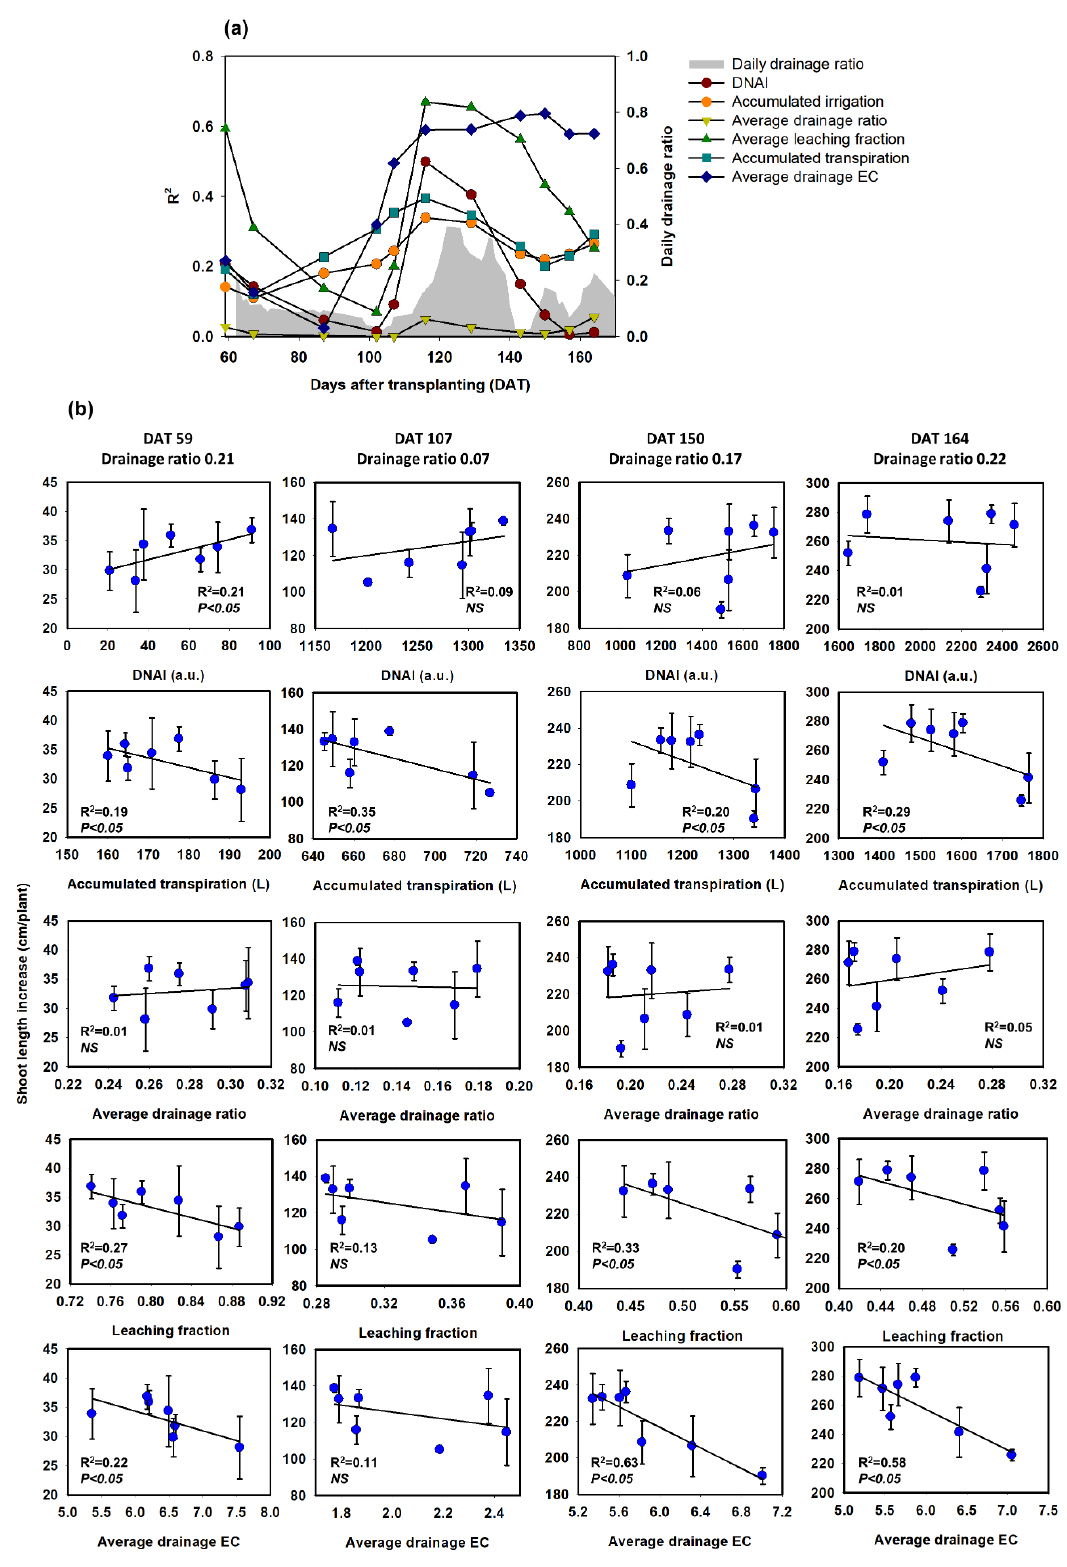
Figure 7. Changes in R 2 values between shoot length increase (mean ± SD) and indicators in water and nutrient management, and DNAI during the period of the DNAI estimation experiment ( a ). Comparison of representative correlation between measured indicators in water and nutrient management, DNAI, and shoot length increase ( b ).